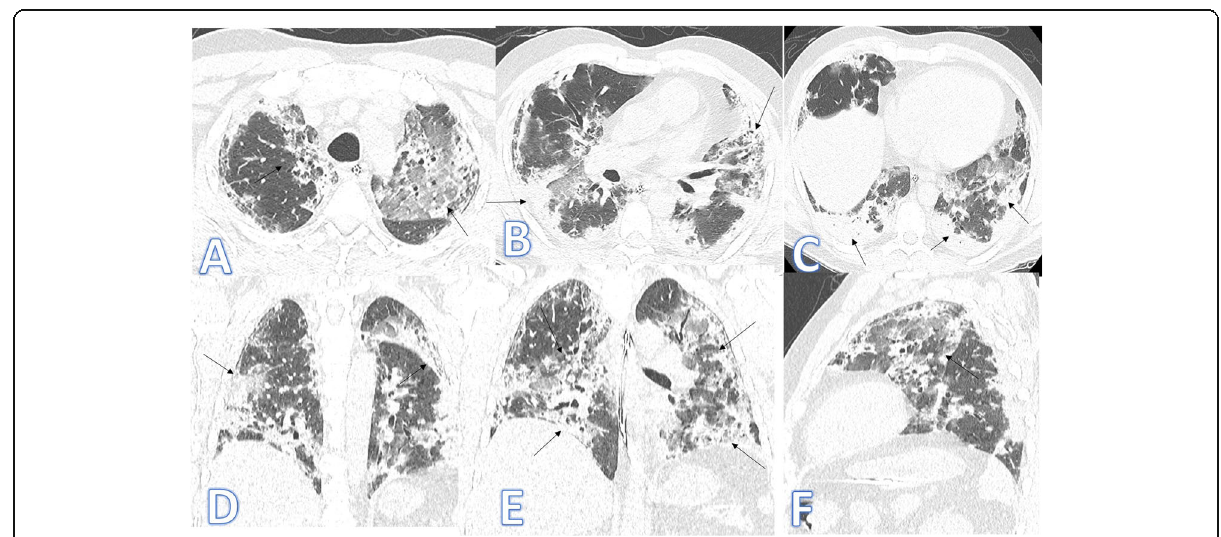
Fig. 3 A 59-year-old male with cough, desaturation with fever. CT chest showed bilateral confluent consolidative patches with GGO and crazy paving appearance (arrows), and it was proven H1N1 on PCR